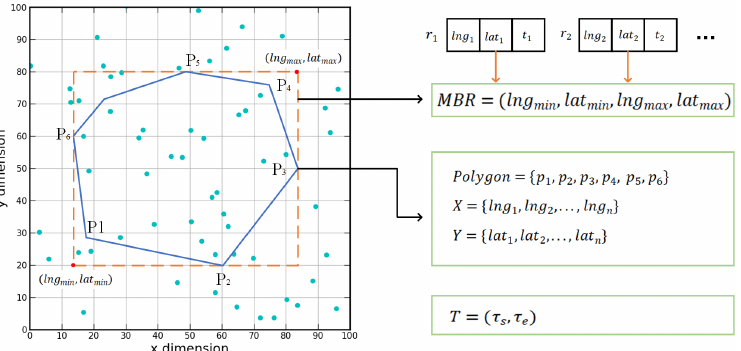
Figure 2. Description of the query condition of spatio-temporal polygon